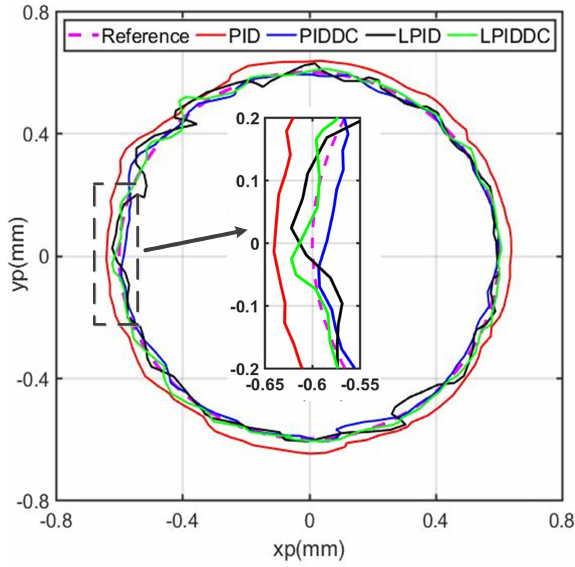
Figure 10. Circular trajectory tracking of the